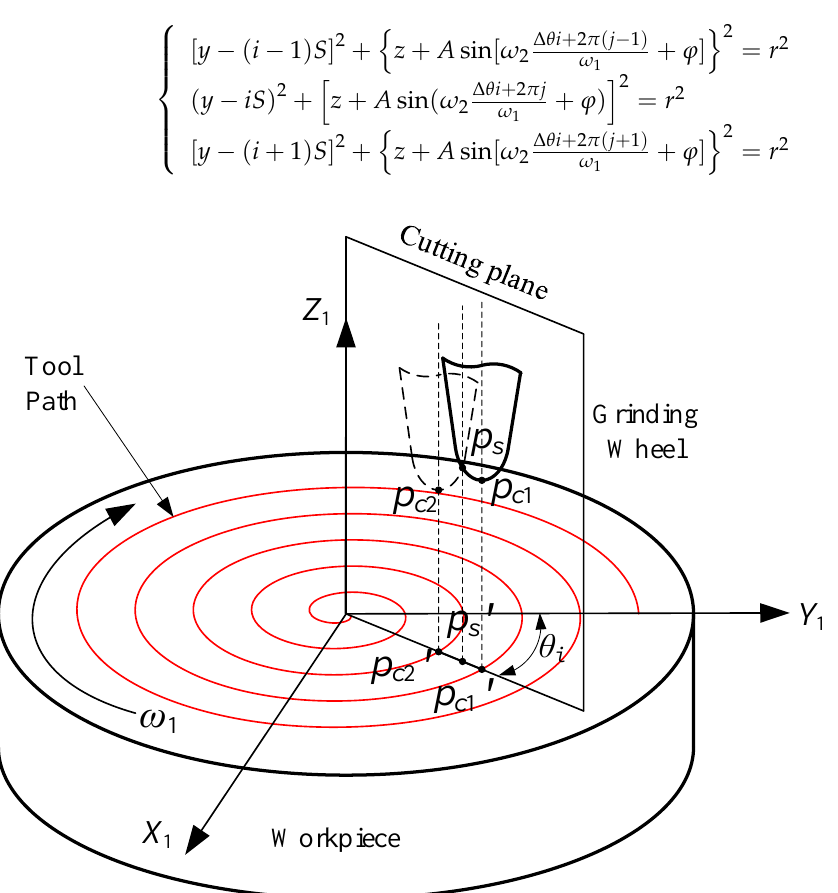
specific consideration method is as follows: